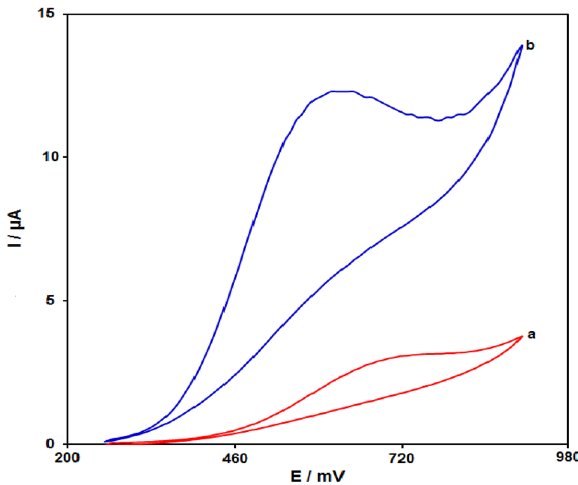
Figure 7. The CVs of ( a ) unmodified SPGE, ( b ) Fe 3 O 4 @ZIF-8/SPGE in 0.1 M PBS at pH of 7.0 when 100.0 µM sumatriptan is present at 50 mV s −1 scan rate.